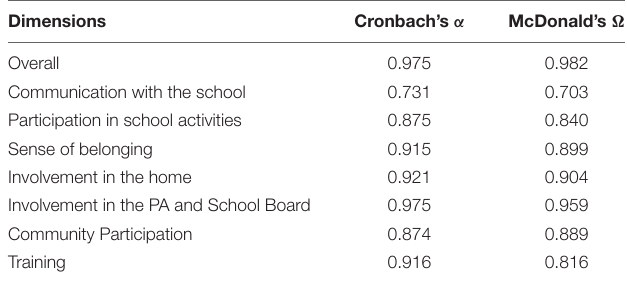
TABLE 7 | Overall reliability of the questionnaire and reliability by